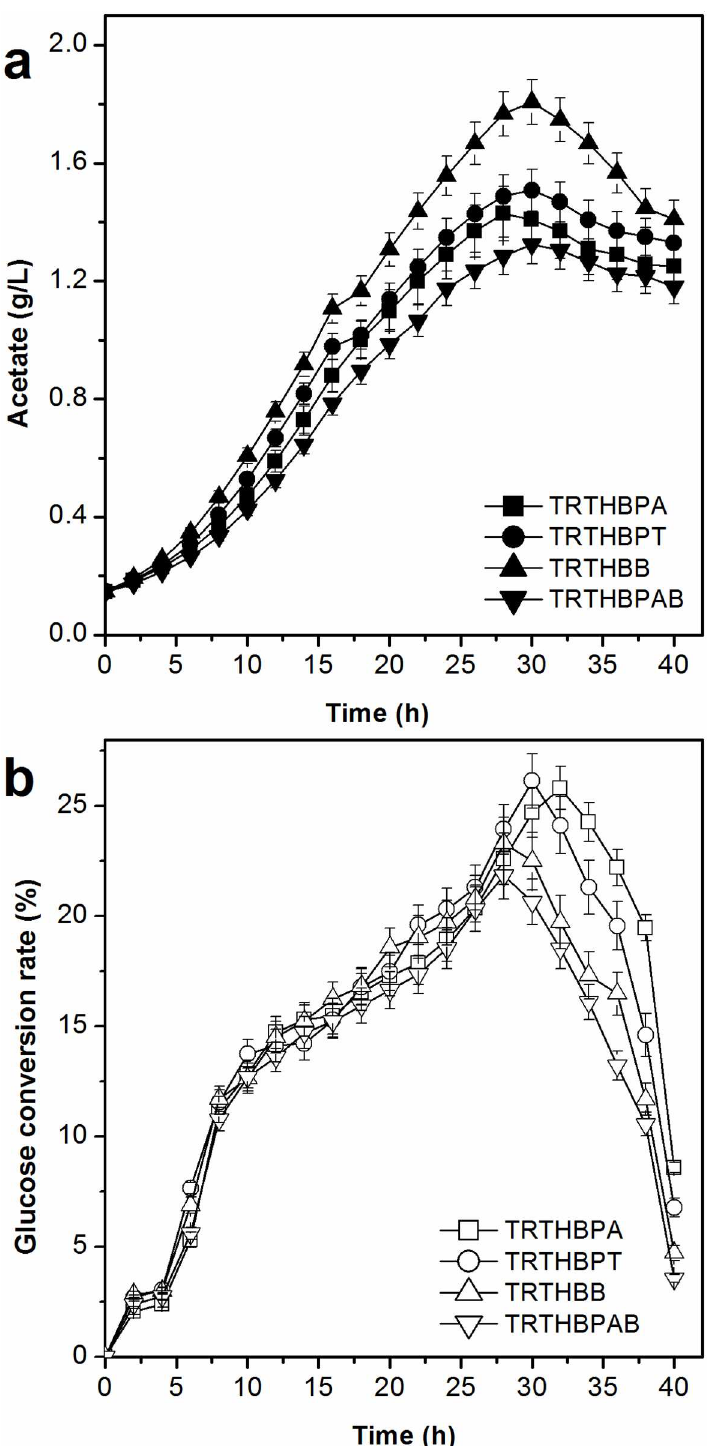
Fig 4. Effect of modifying the genes required for acetatesynthesis on accumulation of acetateand glucose conversion rate in L-tryptophan fermentation ( P < 0.05).